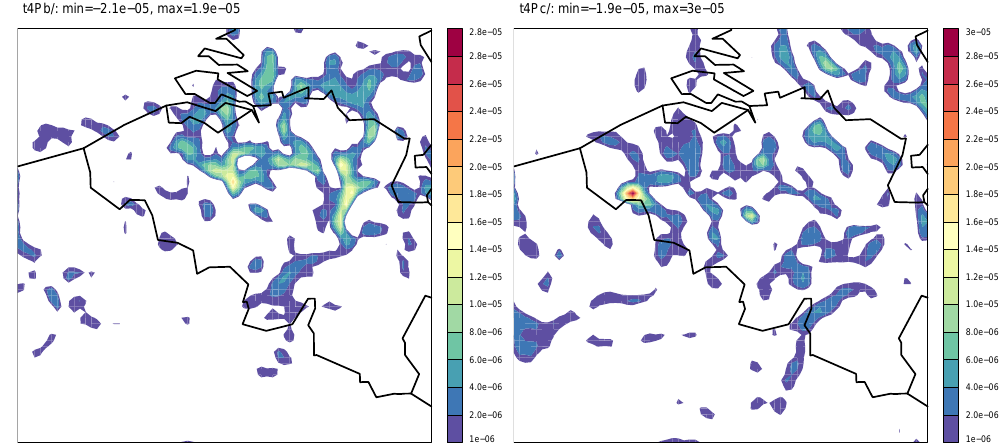
Fig. 4. The same as Fig. 2, positive low-level moisture convergence field. the energy cycle of convection described by CAPE